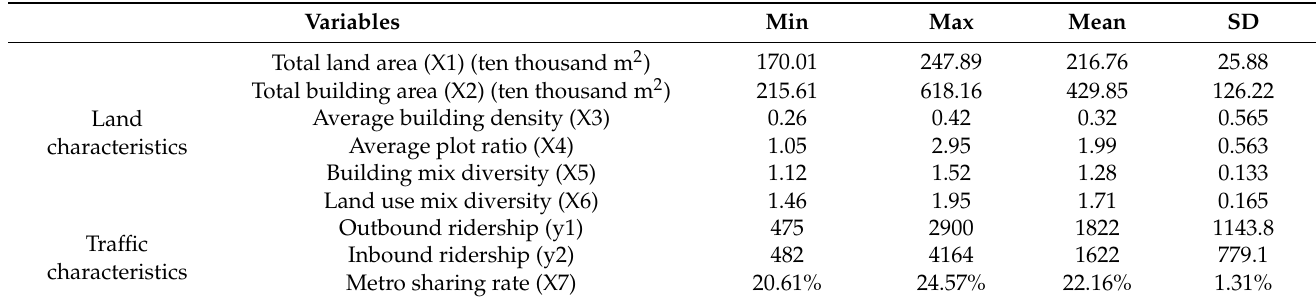
Table 1. The variables and statistics of the nine